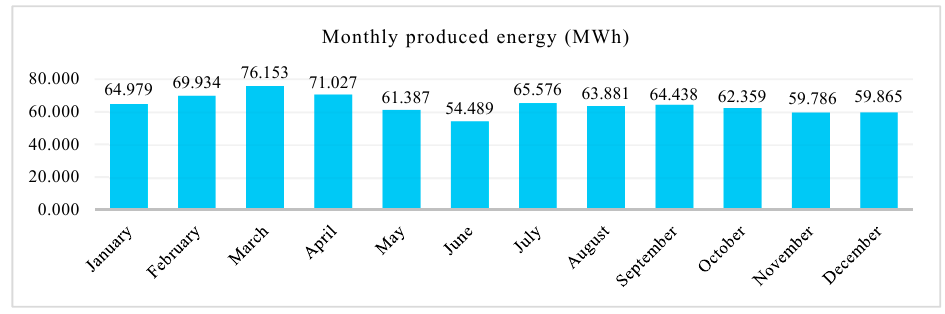
Figure 11. PV plant energy generation (MWh).